Question: Give a one-sentence summary of this figure.
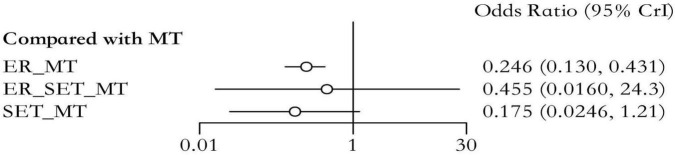
Answer: Forest plot of network meta-analysis for amputation incidence, with MT as the common control. OR < 1 indicates lower amputation risk in the intervention group. ER + MT, endovascular revascularization plus medication; ER + SET + MT, endovascular revascularization plus supervised exercise plus medication; SET + MT, supervised exercise plus medication; MT, medication.